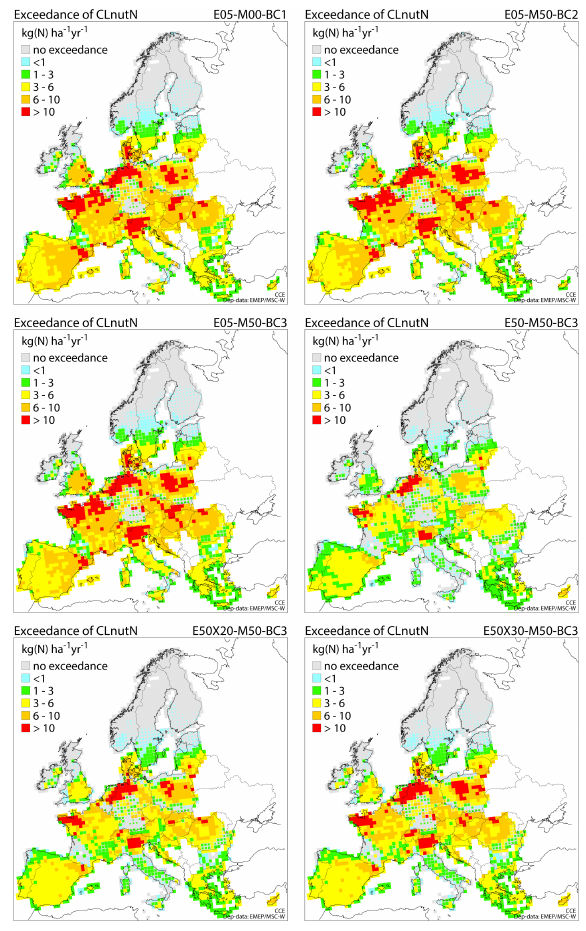
Figure 12. Exceedances of the critical loads for nutrient nitrogen (CL nut (N)) in the EU28 + region, EMEP MSC-W model, for the six